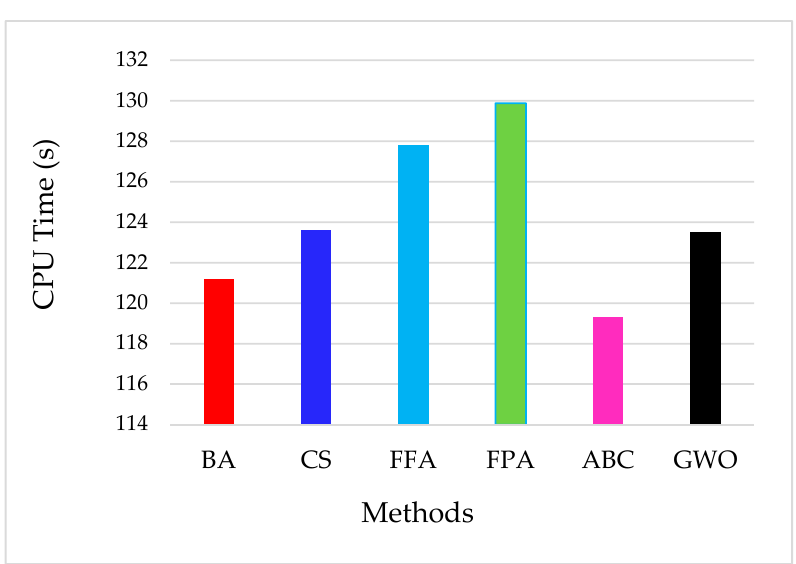
Figure 16. Cost for FOWT problem results.